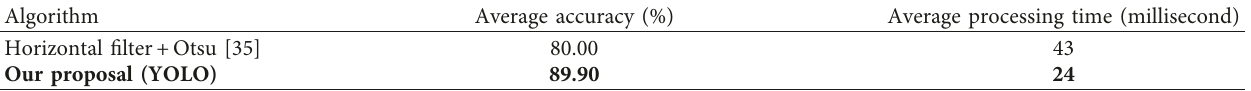
Table 8: Comparison of the proposed system in terms of accuracy and processing time.